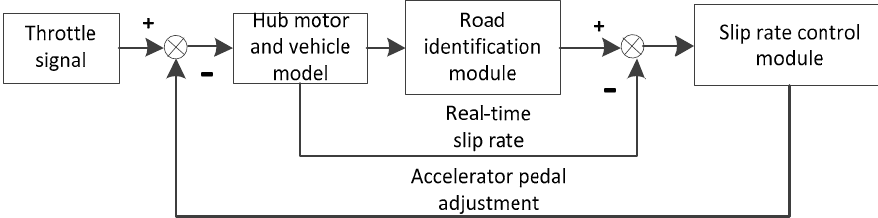
Figure 3. Working process of driving anti-skid system.